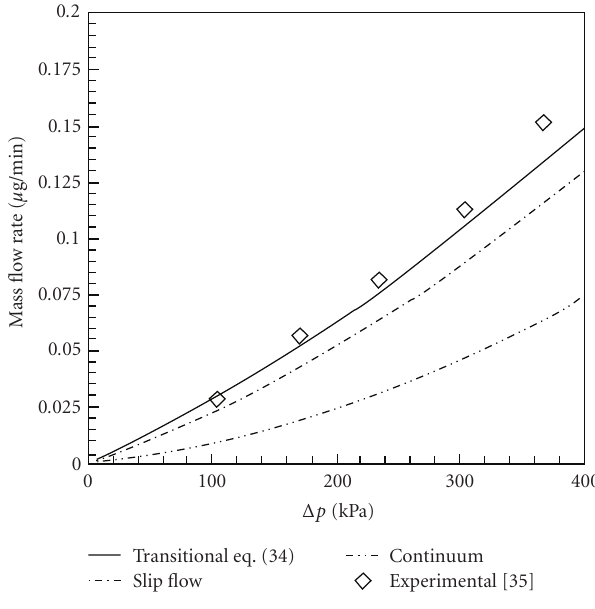
Figure 4: Comparison of the pressure distribution in a 1 . 2 × 40 × 4000 μ m 3 microchannel for helium from the solution of the degenerated (24) (solid line) with experimental data [31] (symbols) and the IP method [26] (dashed lines almost obstructed by the solid lines). Kn o = 0.15579.